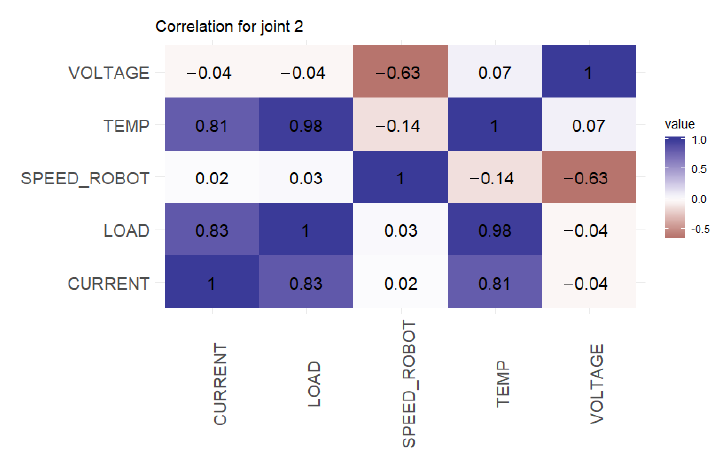
Figure 5. Correlation of joint 1.